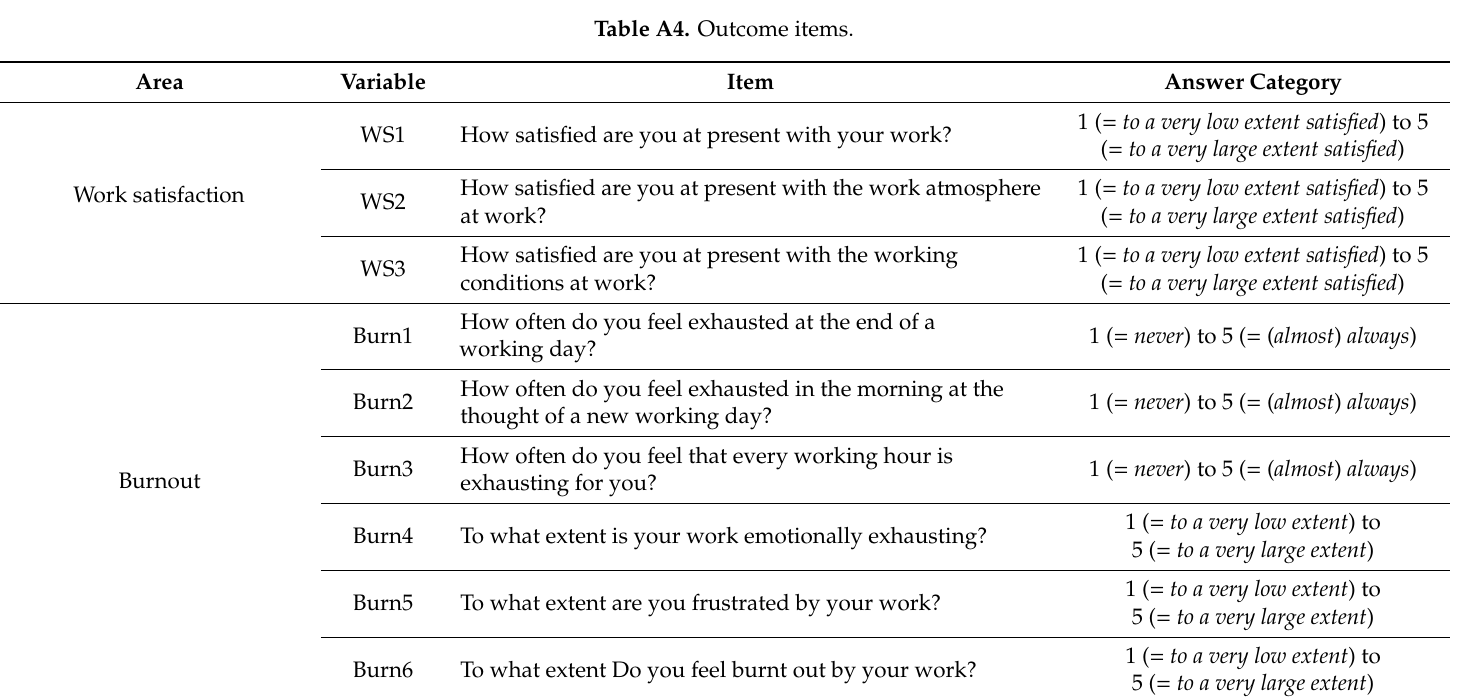
Table A4. Outcome